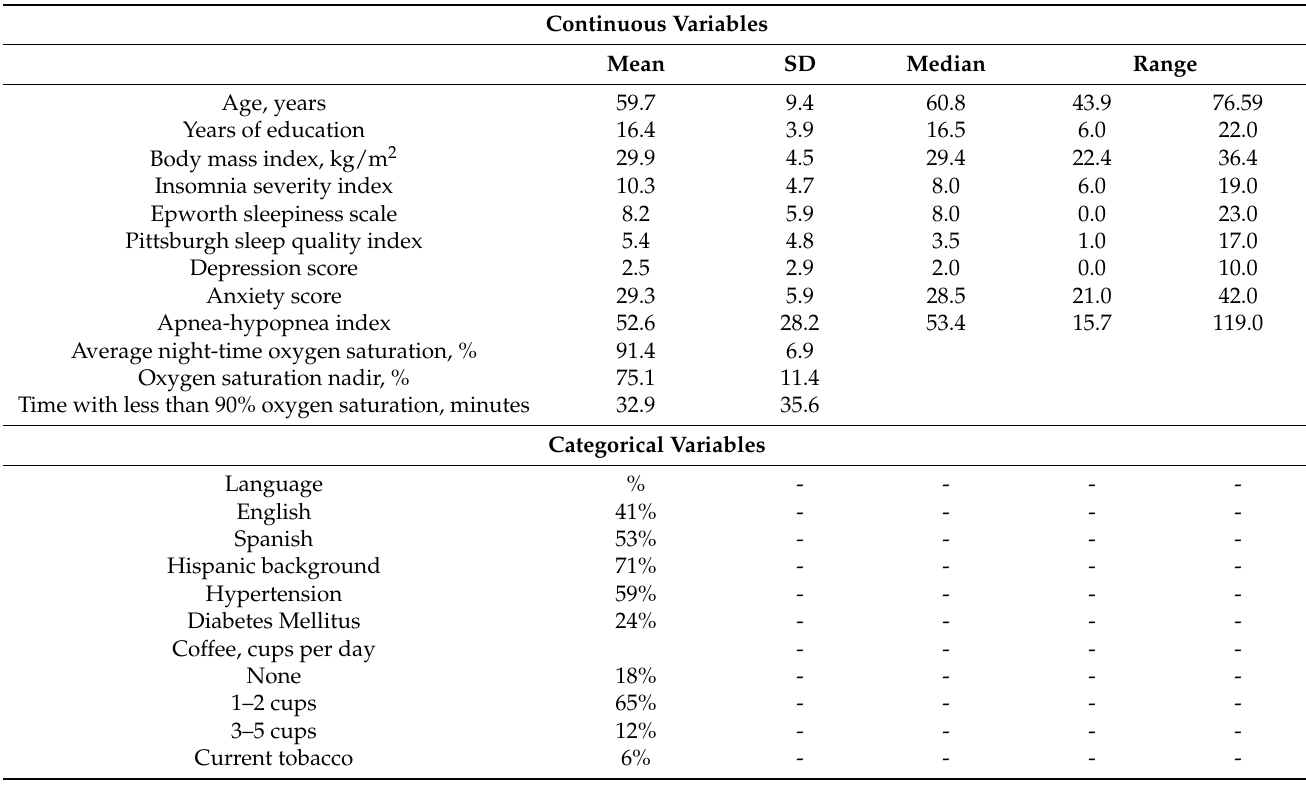
Table 1. Sample characteristics of treatment, naïve patients with moderate to severe sleep